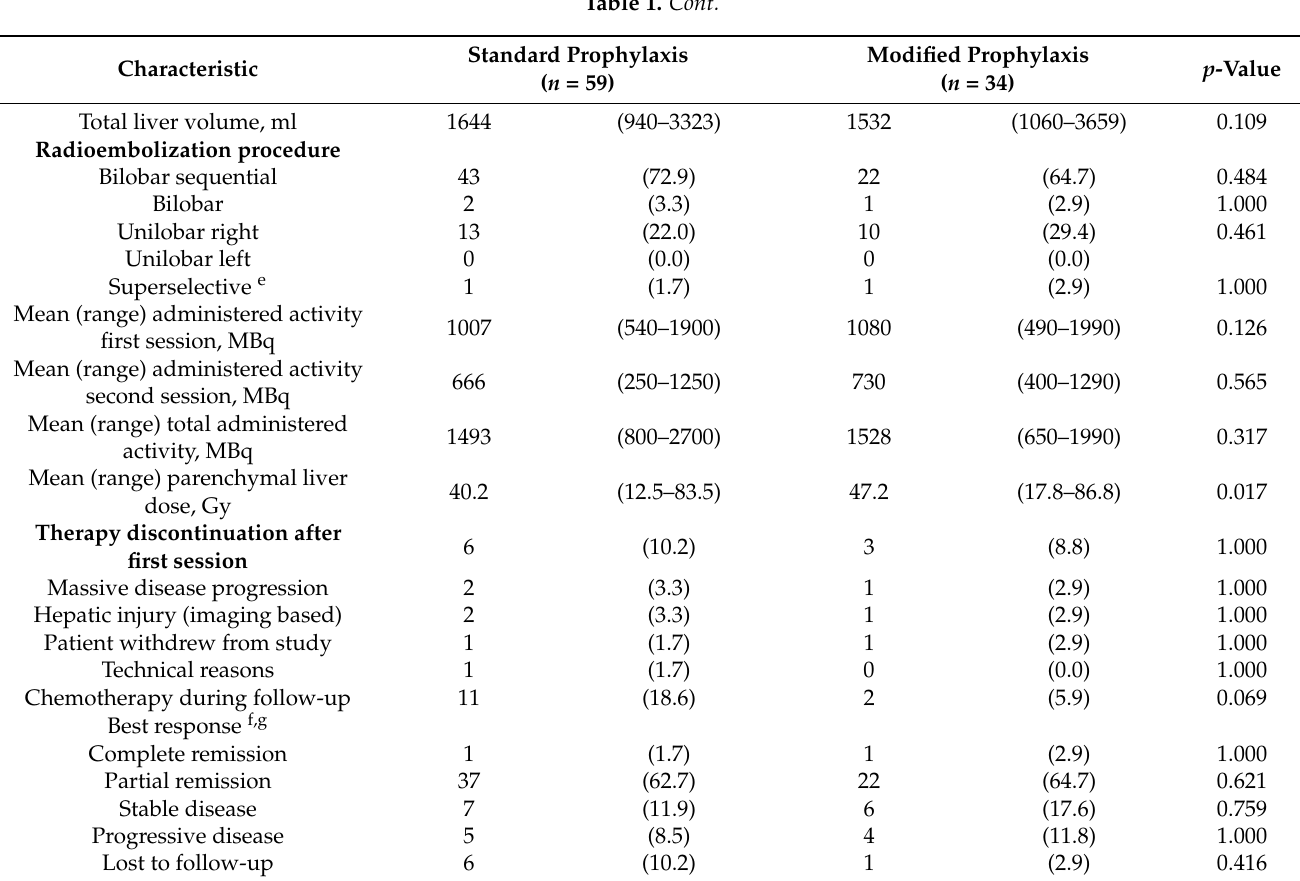
Table S1. Differences between the treatment groups at baseline in bilirubin, prothrom- bin time and aspartate transaminase (ASAT) were within normal range and therefore considered clinically irrelevant. A significant increase in both groups in mean alkaline phosphatase (AP) and ASAT was recorded at follow-up. Alanine transaminase (ALAT) increased significantly in the SP group only. Albumin, cholinesterase, and thrombocytes showed a significant decrease at follow up in both groups. Albumin-bilirubin (ALBI) score significantly increased in both groups. ALBI grade increased in 13 (27.1%) patients in the SP group and 5 (16.7%) patients in the MP group (not